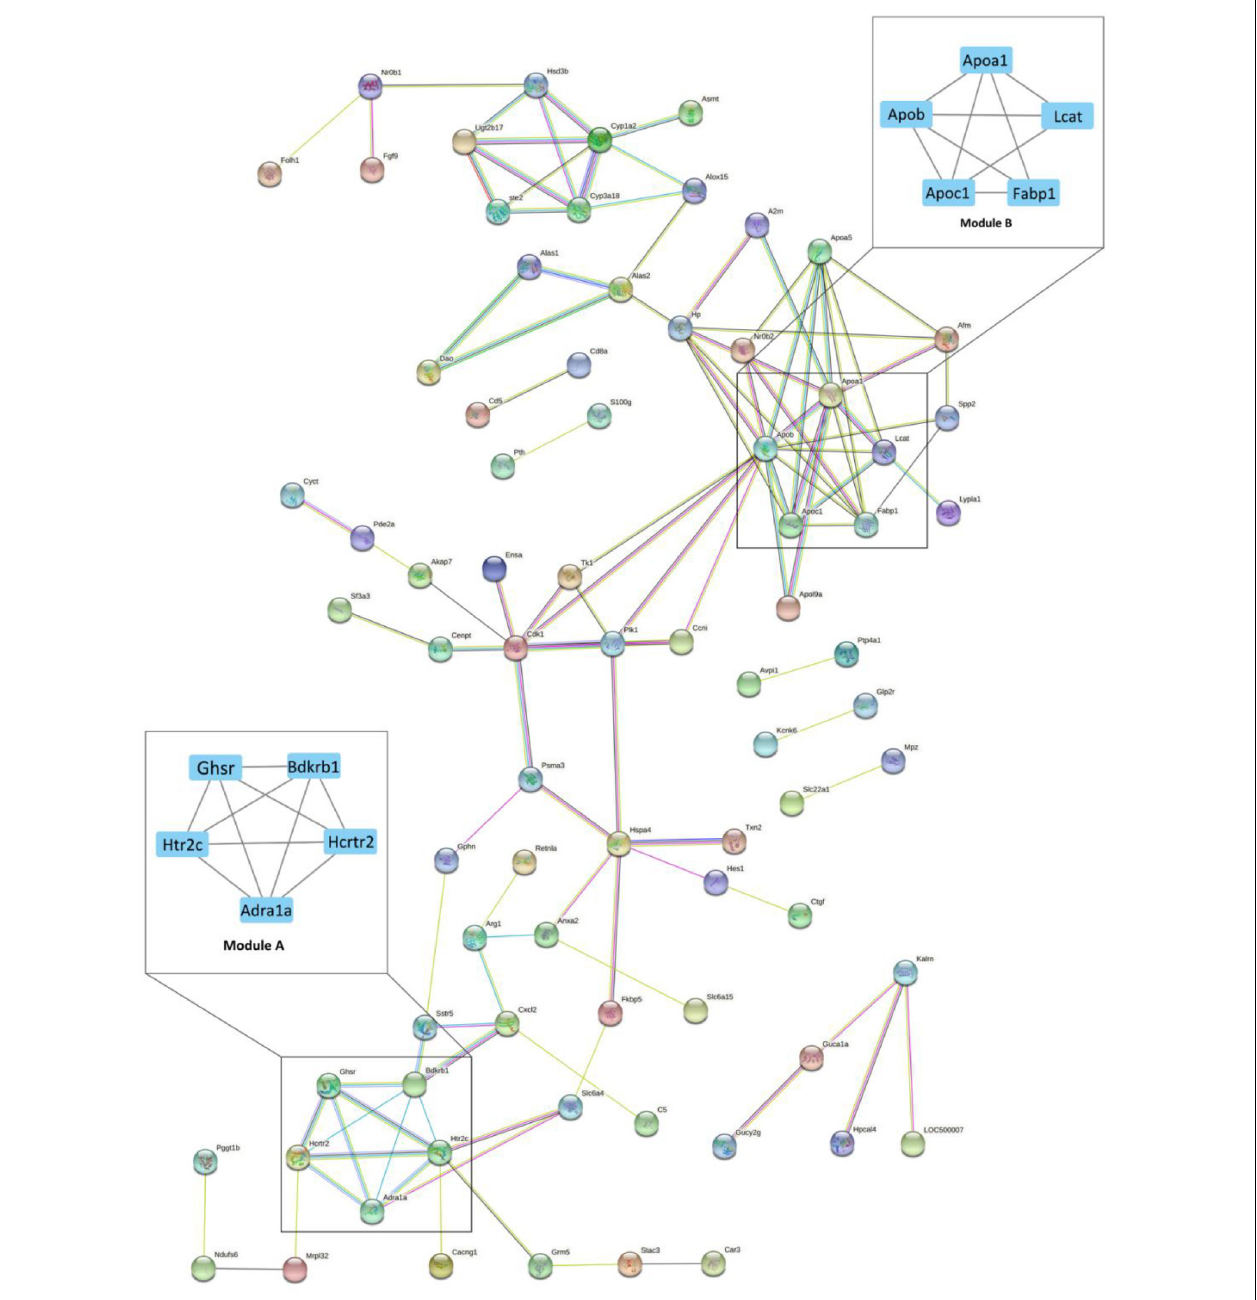
FIGURE 2 | The protein-protein interaction (PPI) network of differentially expressed genes (DEGs) between Acarbose and Water. The 130 significant DGEs were employed for PPI network construction. Each node represented a protein, and each connection represented an interaction. Module A and B were the most significantly enriched functional protein modules. Module A: the hormone receptor module; Module B: the lipoprotein module. The cutoff for module filtration is: MCODE score > 3, and nodes > 3.